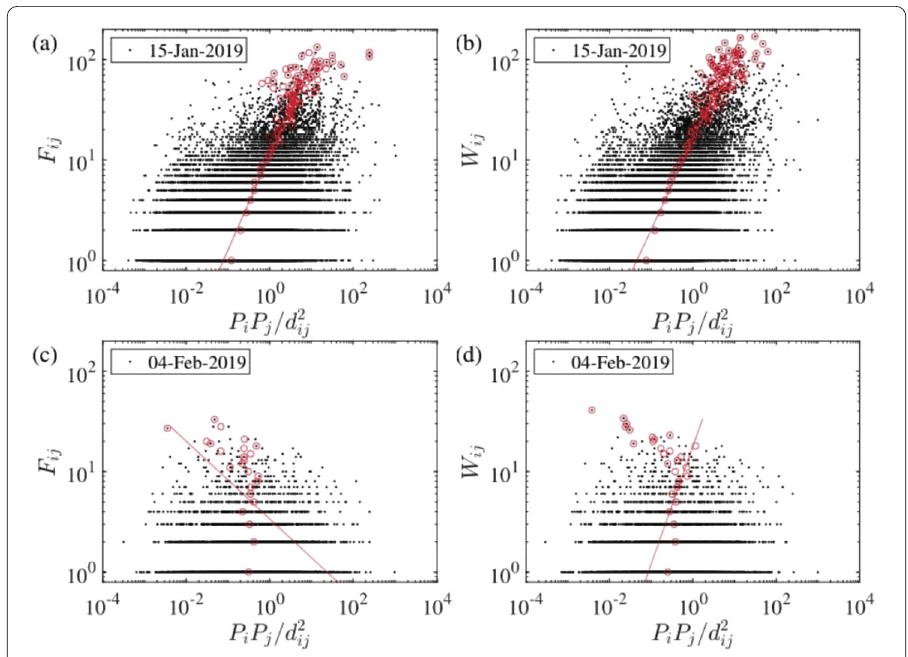
Figure 5 Testing the traditional gravity law with population for the daily directed and undirected freight highway transportation networks. ( a ) The directed network on 15 January 2019. ( b ) The directed network on 15 January 2019. ( c ) The directed network on 4 February 2019. ( d ) The undirected network on 4 February 2019